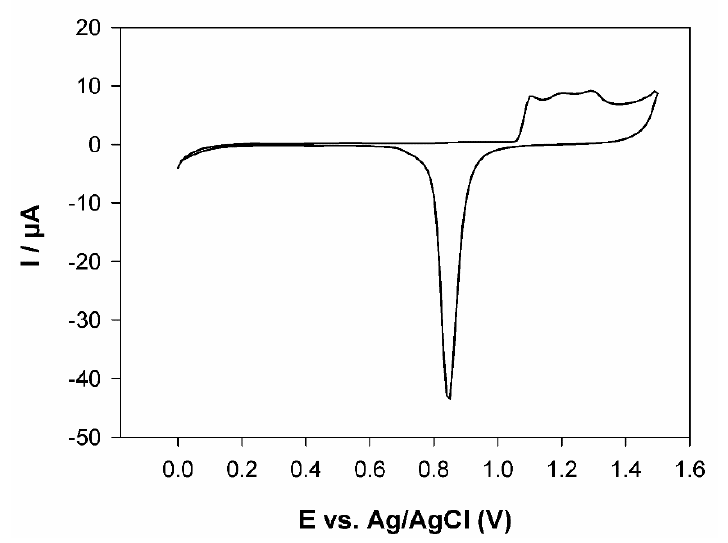
Figure 1. Cyclic voltammogram of the gold electrode in 0.1 M H 2 SO 4 between 0.0 and 1.5 V vs. Ag/AgCl in 0.5 M H 2 SO 4 at a scan rate of 0.1 V s −1 .